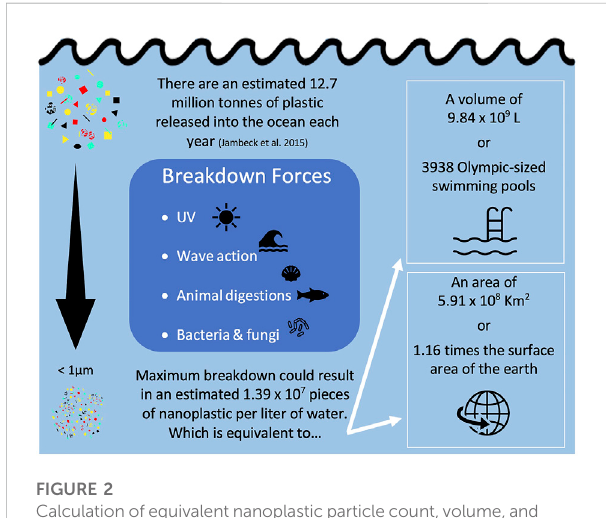
FIGURE 2 Calculation ofequivalentnanoplasticparticlecount,volume,and surface area using a mass balance approach detailed in Supplemental spread